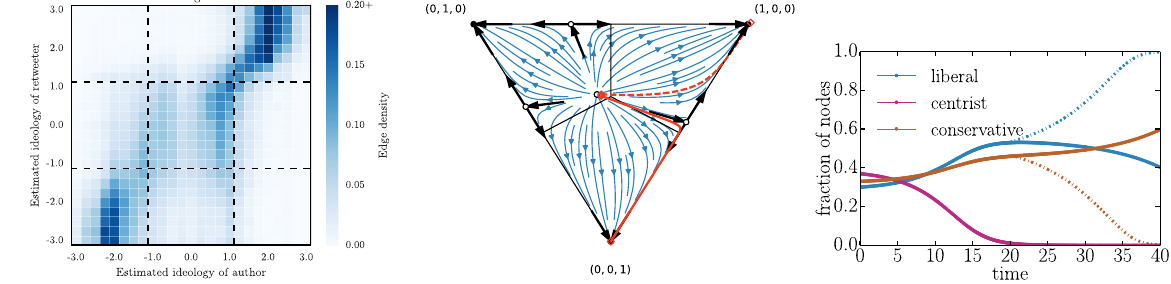
Figure 8. Application of our model to Twitter data. (left) Shown are strategies of retweets for different inferred ideologies of authors, according to (and normalized) for every inferred ideologies of retweeters using the federal budget data. The structure of strategies leads to a natural parametrization in terms of three ideologies showed by dotted lines: liberal (smaller than − 1.0), centrist (between − 1.0 and 1.0) and conservative (above 1.0). Coarse- graining of retweets over this 3 by 3 matrix, then normalizing per row, leads directly to a possible P matrix. (middle) We obtain P matrix and compute the flow diagram with our general analysis (see Supplementary Methods). We highlight two possible time series to illustrate how small changes in initial conditions can lead to drastically different outcomes. (right) One possible time series (highlighted in solid line on the flow diagram) shows the transient behavior. The dotted curves do not exactly correspond to the dotted curve in the flow diagram, but rather to a scenario where strategies are re-scaled (or re-normalized) to remove the centrist ideology from the system once its frequency falls below 1% of the